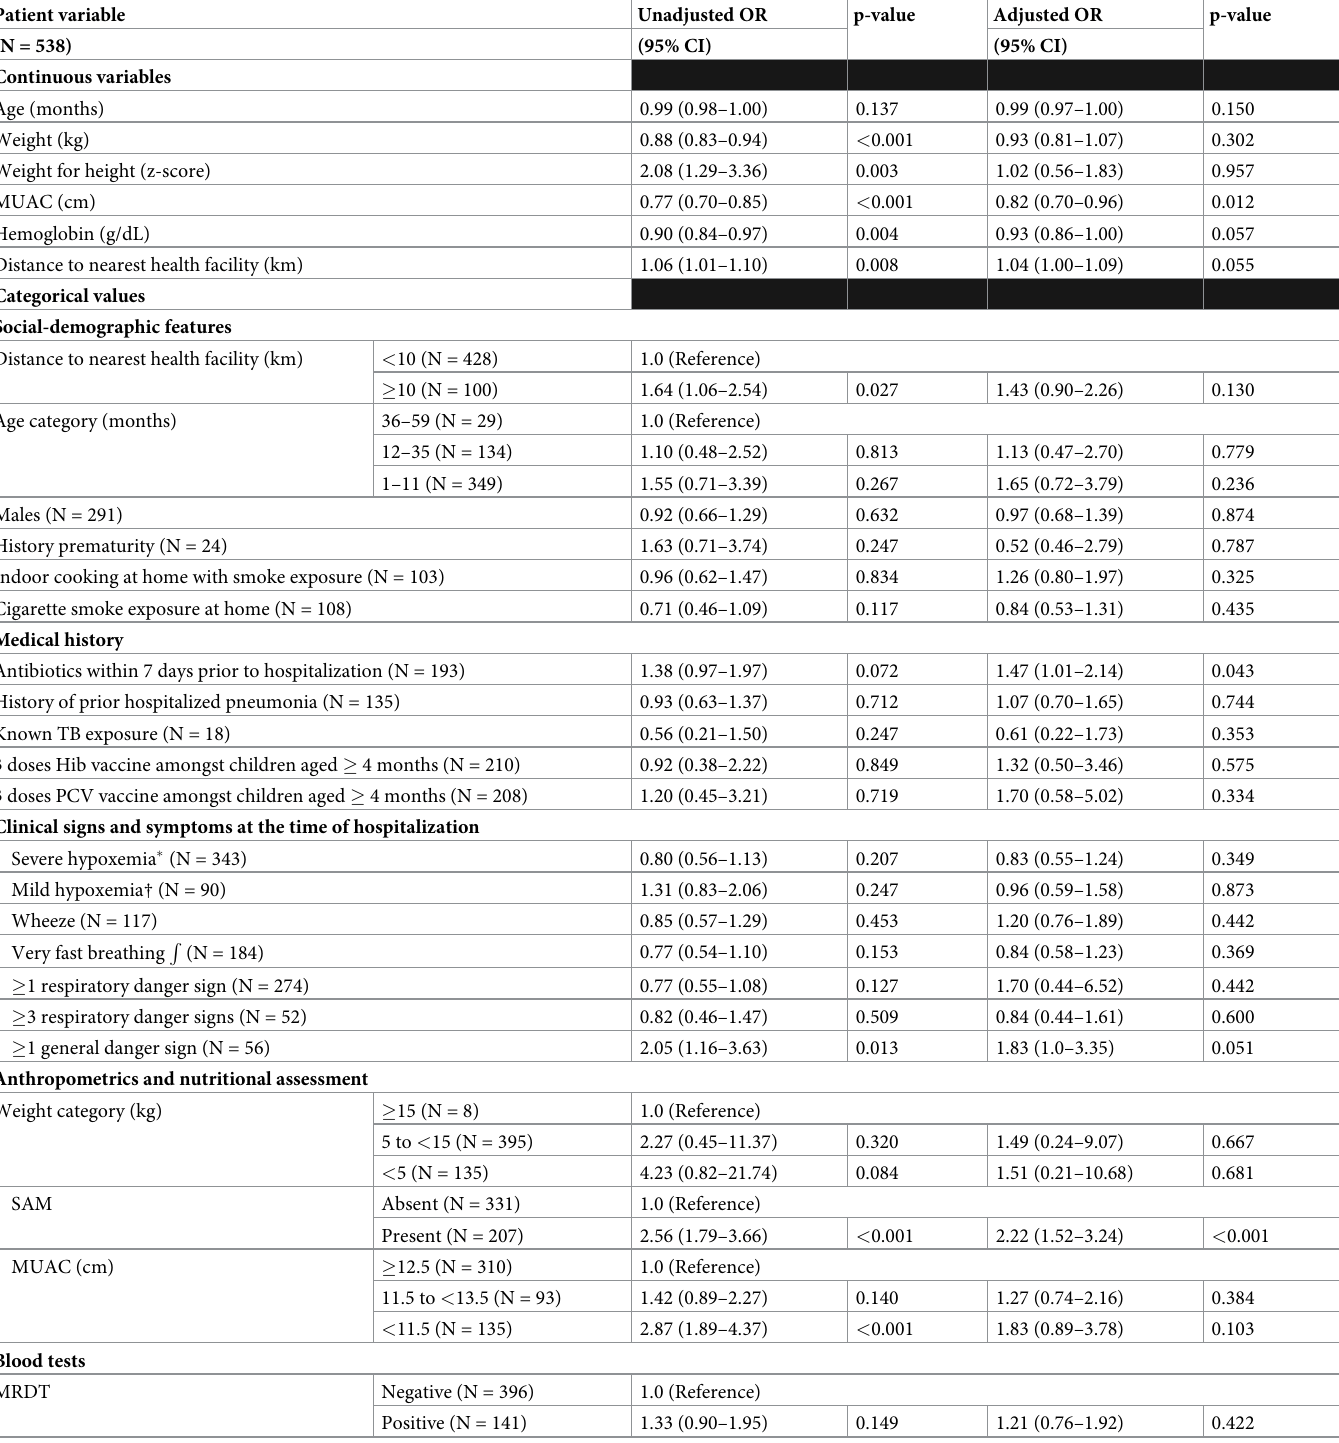
Table 5. Predictors of antibiotic treatment